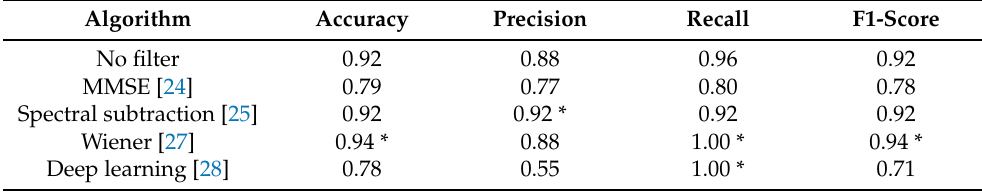
Table 3. Babble Noise SNR 0. * is the best result for each particular